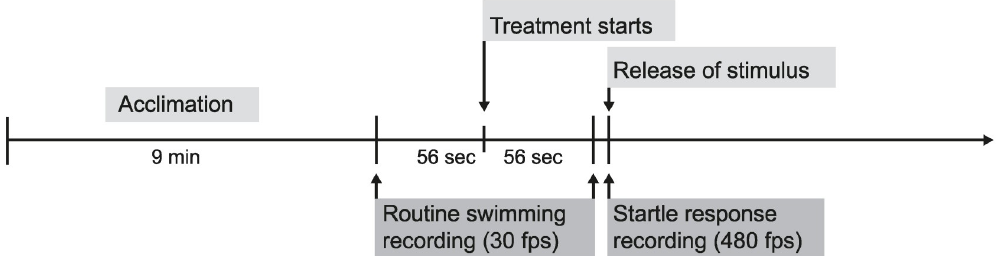
Fig 2. Experimental timeline. Each individual was placed in the experimental arena for nine minutes to acclimate. The routine swimming was recorded one minute before and one minute after the beginning of the sound treatment (ambient playback, 4-stroke noise playback, or ship noise playback). After recording routine swimming, a stimulus was released, and the fast-start escape response